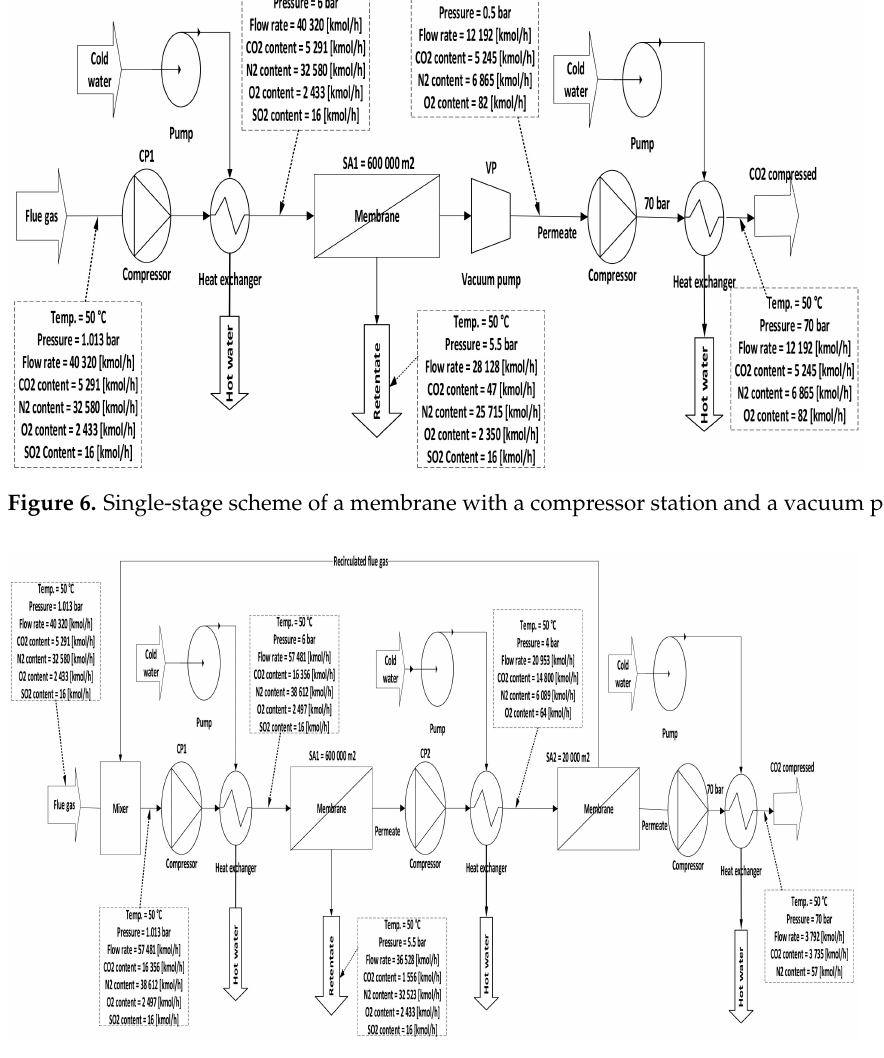
Figure 7. Two stages of a membrane with different compression